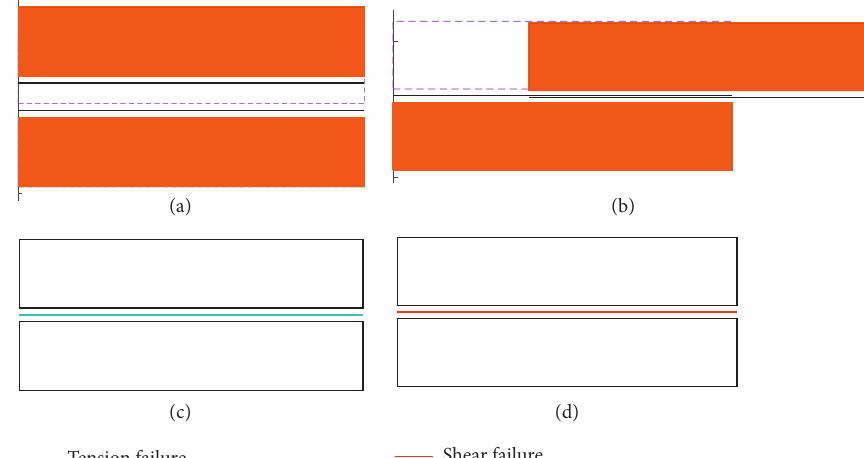
Figure 2: Tension (a, c) and shear (b, d) tests on two blocks specimens. Deformed configurations (a, b) and interface damage (c, d).